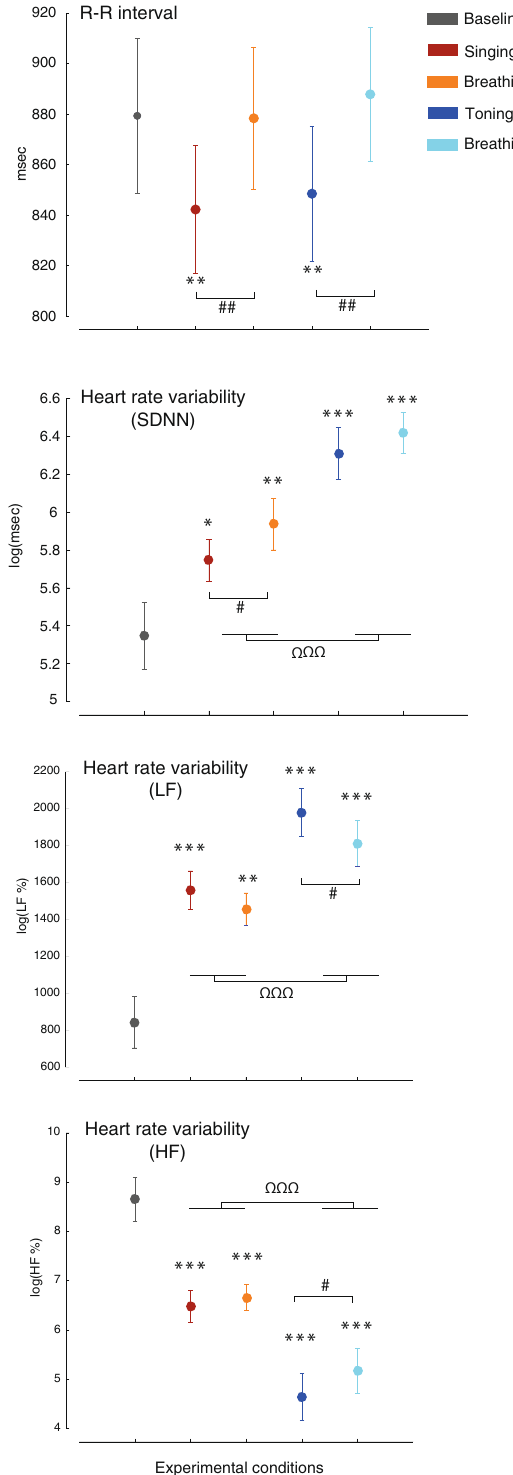
Figure 2. Cardiovascular data. Heart rate increases during vocal production, similarly for song singing and toning. Overall heart rate variability (SDNN) increases in all conditions relative to baseline, significantly more during toning compared to singing, and significantly more during silent breathing compared to the matched vocal conditions. For LF and HF heart rate variability see text. All conventions as in Fig.